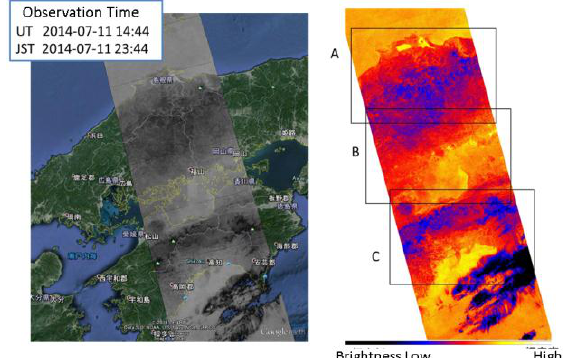
Figure 6. Night image of the Chugoku region and Shikoku in Japan (JST 23:44).